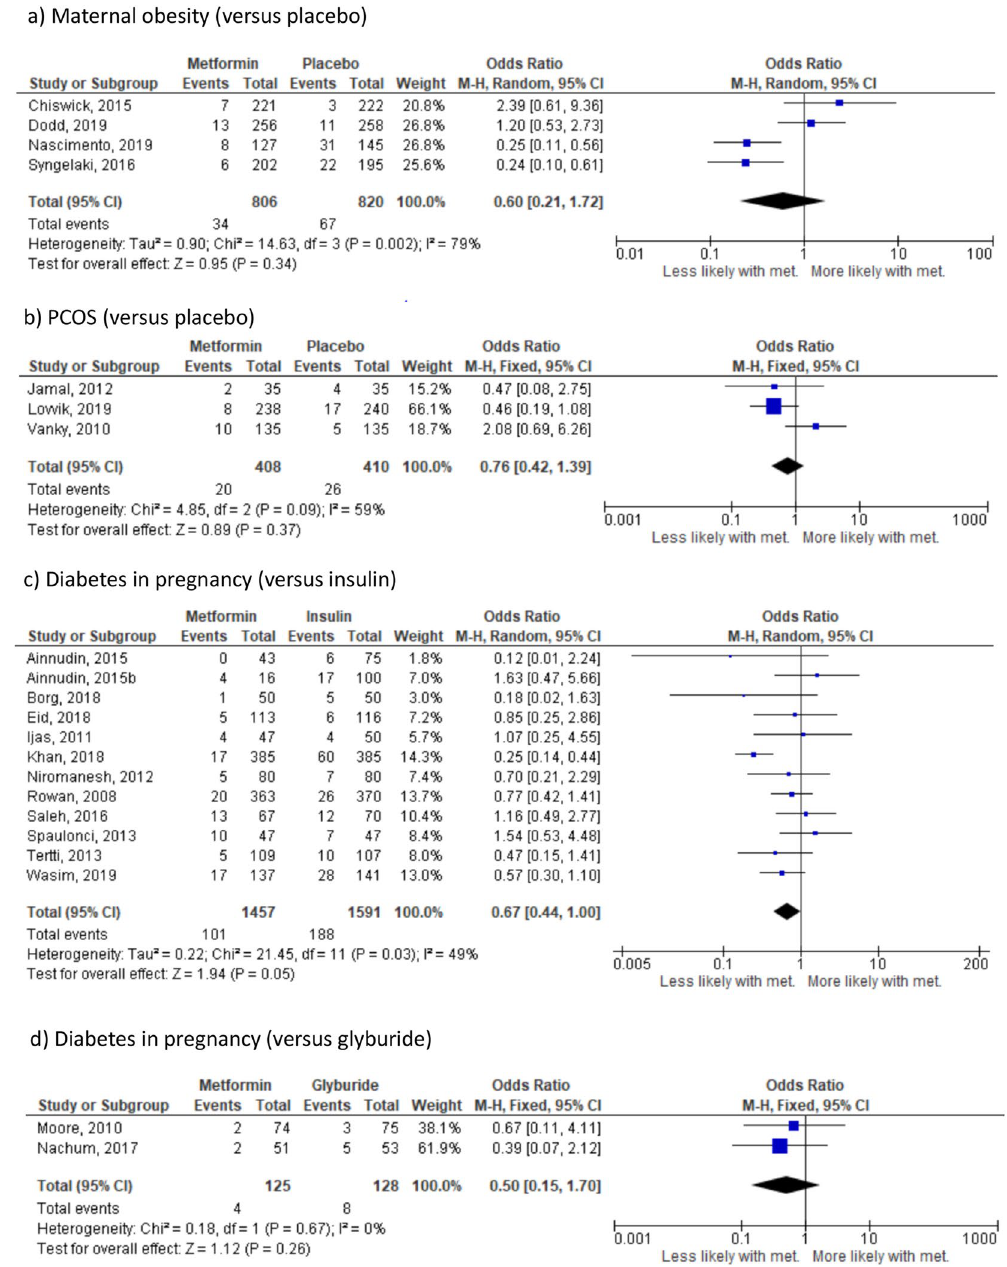
Figure 2. Effect of metformin randomisation upon pre-eclampsia (all indications), based on 21 studies including 5979 pregnancies. Odds ratio, random-effects model, 95%